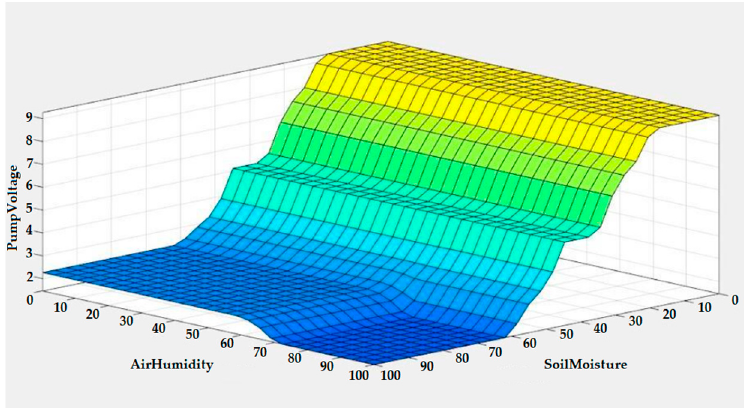
Figure 9. Surface graph of soil moisture and air humidity vs pump voltage.